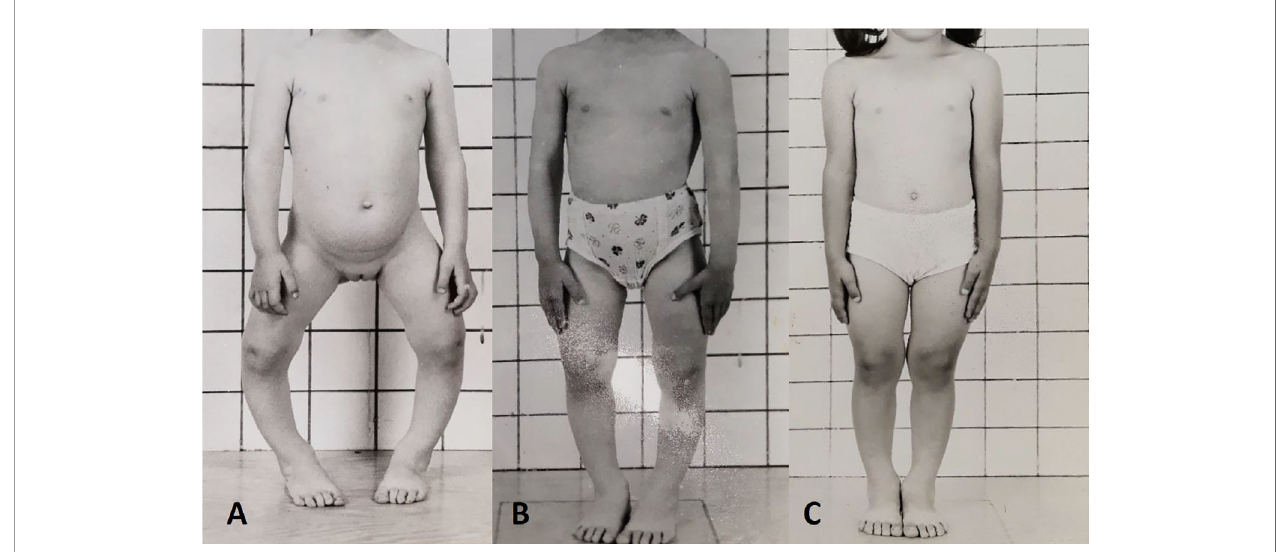
FIGURE 3 | Response to conventional medical treatment with phosphate and active vitamin D supplements in XLH. (A) Clinical presentation at age 3 years. (B) One year, (C) 2 years after initiation of conventional